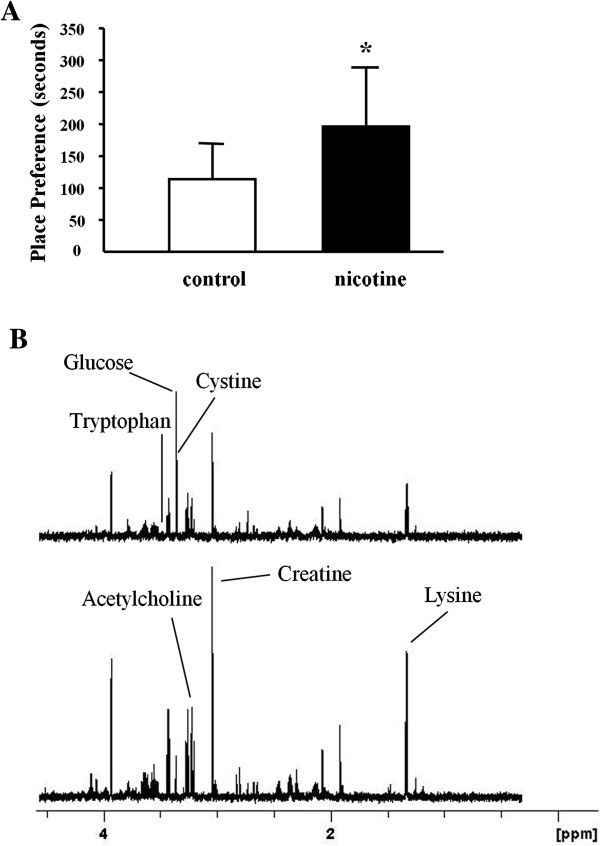
Scores of nicotine-induced conditioned place preference (A) and 600 MHz CPMG 1H NMR spectra of the striatum from mice (B). (A) After repeated 0.5 mg/kg nicotine treatment, mice developed a significant preference for nicotine-paired side (n = 8, p < 0.05, F = 5.886); (B) the upper is control group; the bottom one is nicotine group.